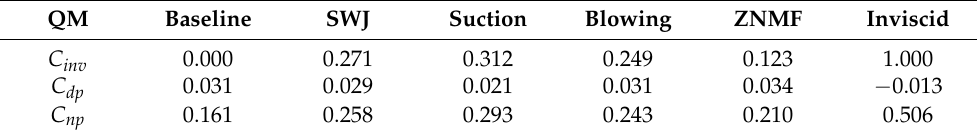
Table 2. Comparison of quality metrics (QM) for different AFC methods at C µ = 0.11%.